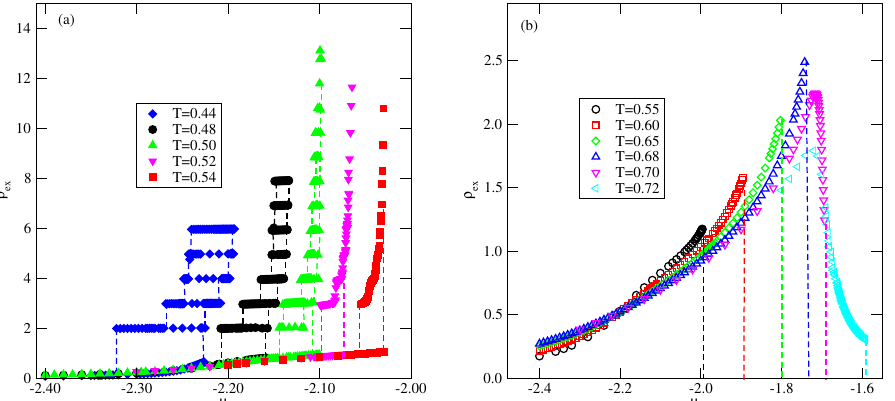
Figure 7. The adsorption–desorption isotherms for the system with u AB = 0, u BB = − 1.0 and V o = − 1.0 at different temperatures (given in the figure), below ( a ) and above ( b ) the dewetting transition